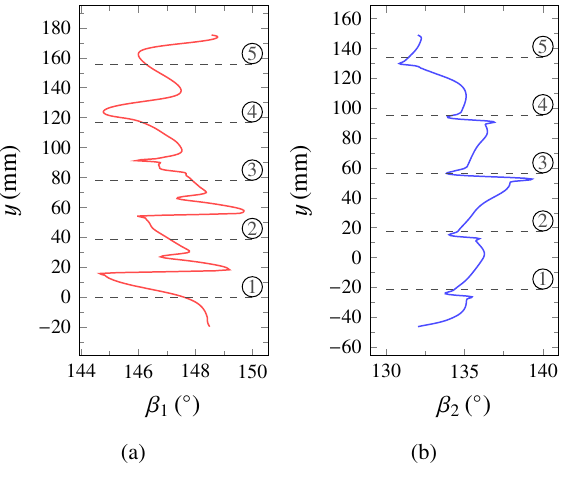
Fig. 8 . Flow angle β 1 in the plane in the normal distance of 15mm upstream the cascade (a) and β 2 in the plane 15mm downstream the cascade (b).